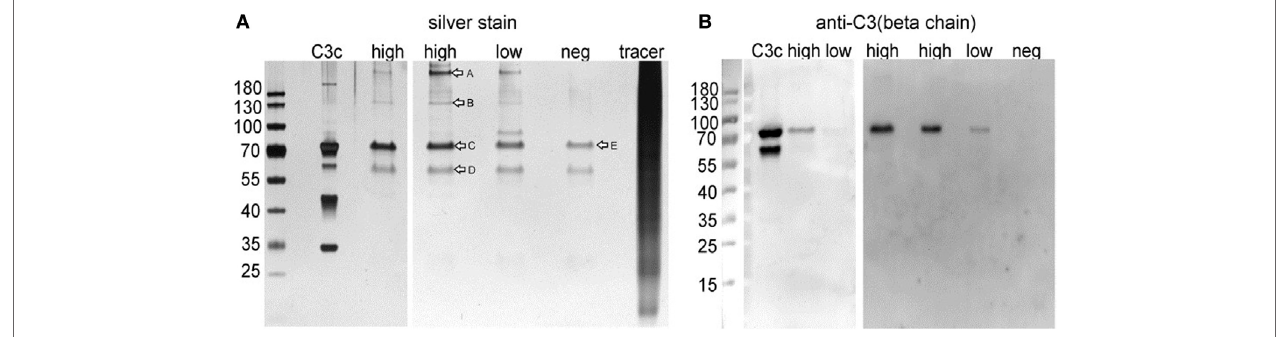
FigUre 2 | (a) Silver stain of immunoprecipitated ELISA products and (B) Western blot analyses using an anti-C3 β -chain antibody. Commercially available C3c protein isolated from human plasma was run as positive control. High: pooled IP samples of sera that gave highest ELISA signals; low: pooled IP samples of sera that gave lowest ELISA signals; neg: negative control using dilution buffer from the ELISA kit; tracer: competitive tracer reagent from the ELISA kit. Letters in (A) indicated bands analyzed by MS after tryptic in gel digestion (Table S2 in Supplementary